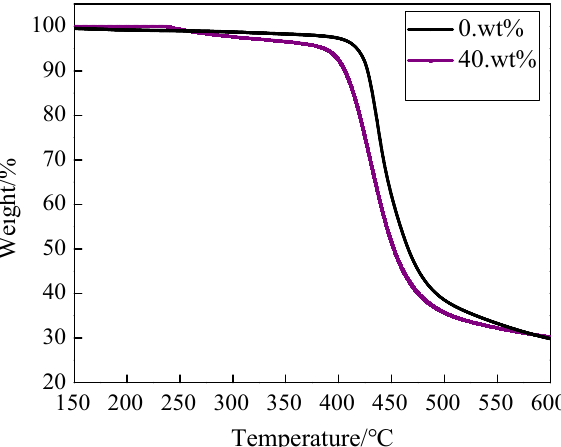
Figure 10. Thermogravimetric curves of modified BMI with different content of HBPI.